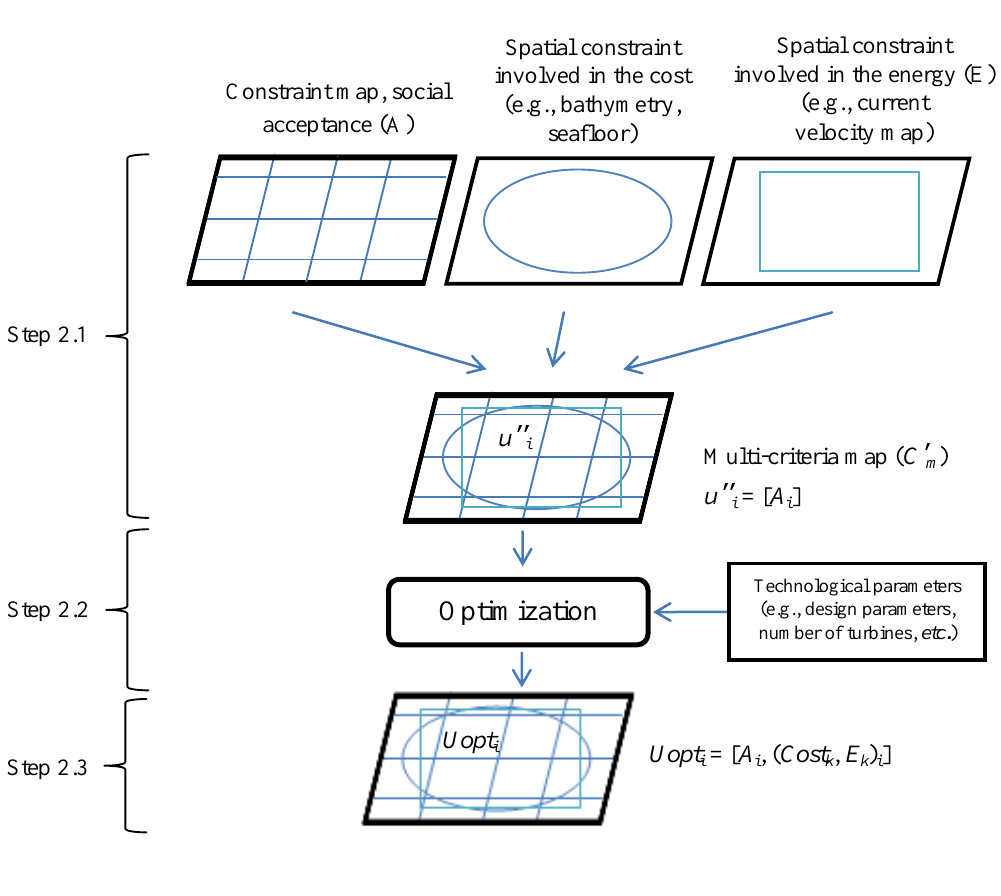
Figure 4. Second step of the